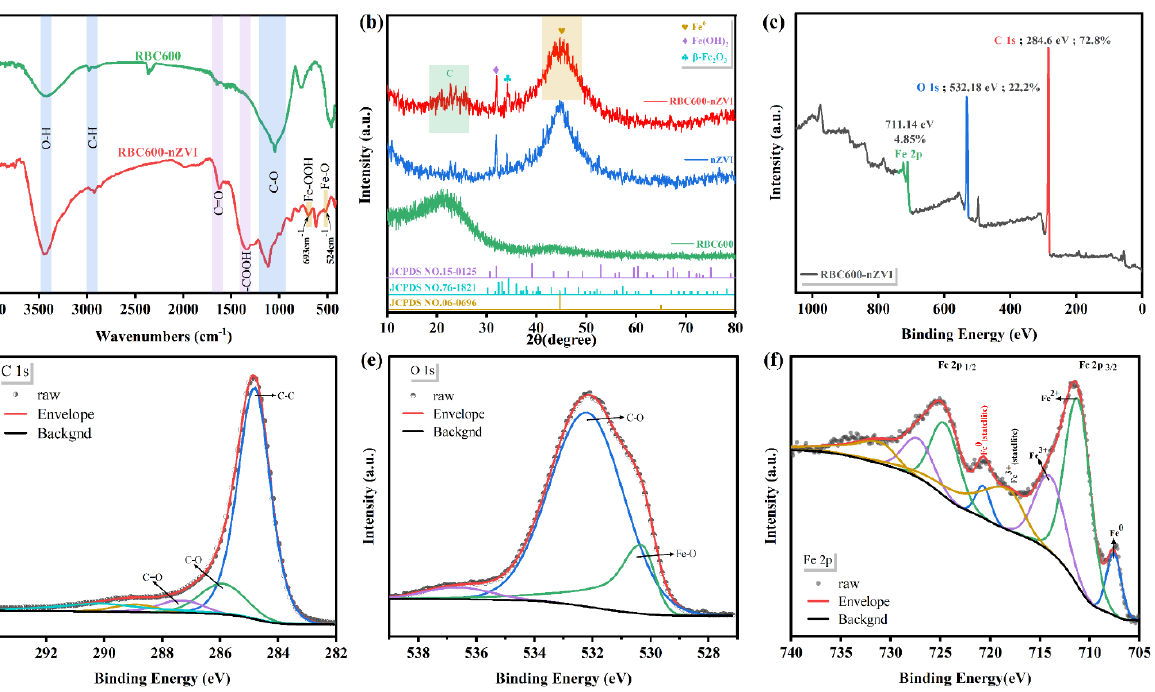
Figure 3. FTIR spectra pertaining to the RBC600 and RBC600–nZVI ( a ); XRD patterns of RBC600, nZVI, and RBC600–nZVI ( b ); XPS spectra of RBC600–nZVI prior to reaction with Cr(VI): Full survey ( c ), C 1s ( d ), O 1s ( e ), and Fe 2p ( f ) binding state levels.